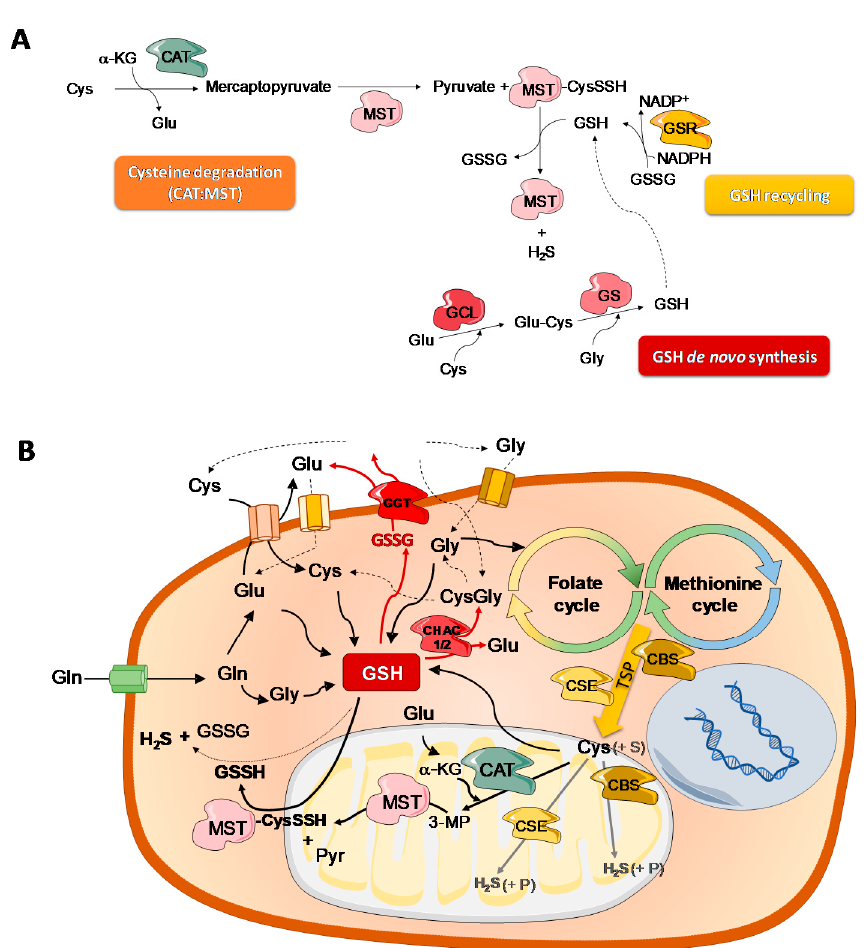
Figure 3. Interdependence of CAT:MST axis, glutathione (GSH) bioavailability and cysteine metabolism. ( A ) Glutathione (GSH) bioavailability depends on de novo synthesis and recycling. GSH is